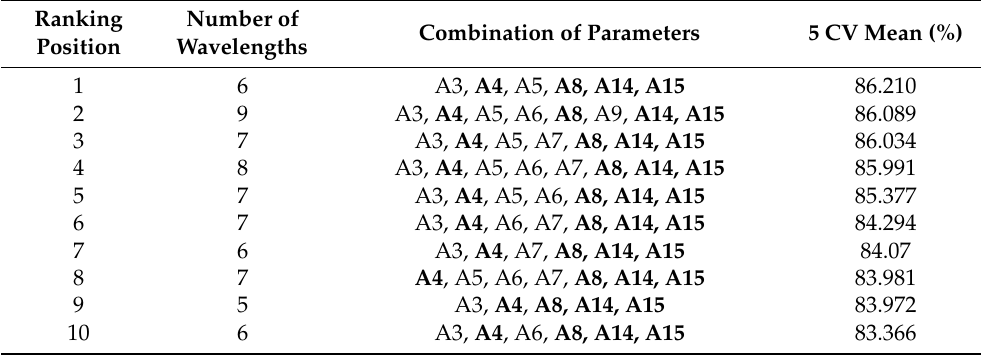
Table 10. Top 10 ranking for multiple wavelength usage for brown eggshells with hyperparameter op- timization and decreased C parameter value. Parameters given in bold indicate the key wavelengths for brown eggs